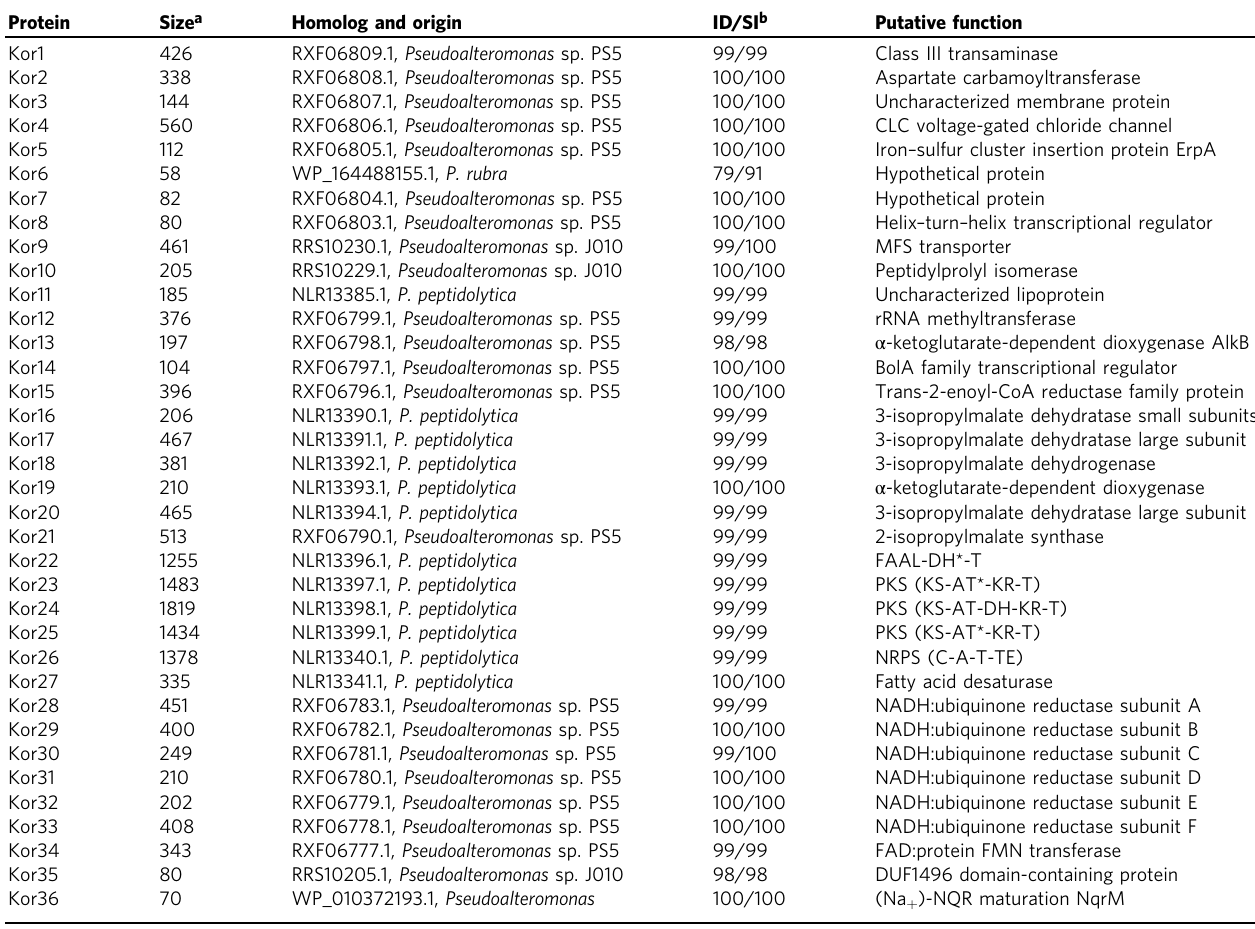
Table 1 Features of the gene products in the predicted korormicin (kor) clusters of Pseudoalteromonas McH1-7.